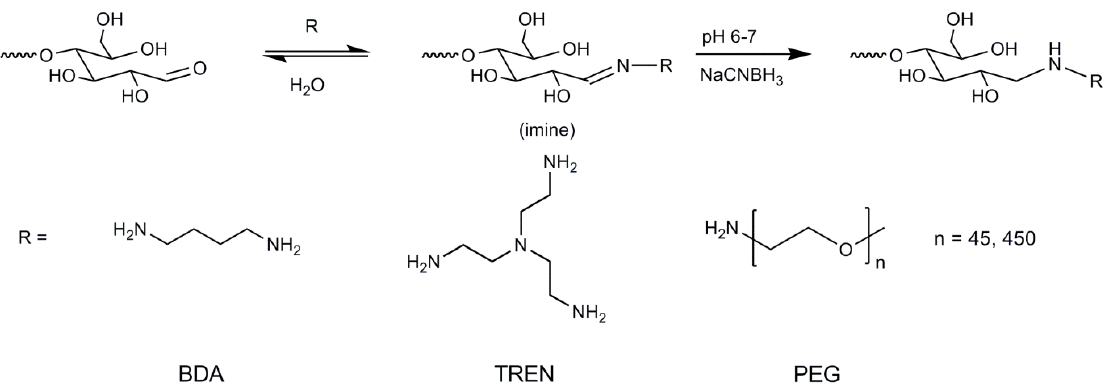
Figure 4. General reaction mechanism of a reductive amination with the reducing group of a